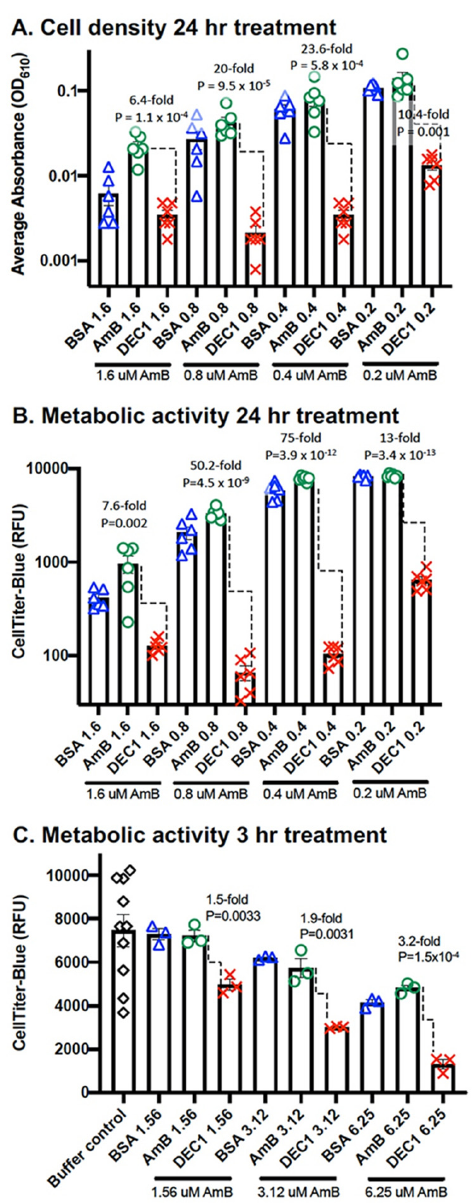
Figure 5. Quantitative DEC1-AmB-LL inhibition and killing assay based on cell density and metabolic activity. ( A ) Microtiter plate-grown cells were treated with liposomes delivering the indicated concentrations of AmB for 24 h and cell density was quantified. ( B ) The same 24 h microtiter plate-grown cells were incubated with CTB reagent and metabolic activity was quantified. ( C ) R. delemar sporangiospores were diluted into liquid RPMI + MOPS media and incubated at 37 °C for 8 h. R. delemar hyphae were then treated for 3 h with either BSA-AmB-LLs, AmB-LLs, or DEC1-AmB-LLs at the noted AmB concentrations or treated with buffer alone (buffer control). The residual metabolic activity was quantified as relative fluorescence units (RFU) generated from the electrochemical reduction of the CellTiter-Blue reagent to a fluorescent product (N = 3). Standard errors, fold differences, and p -values are